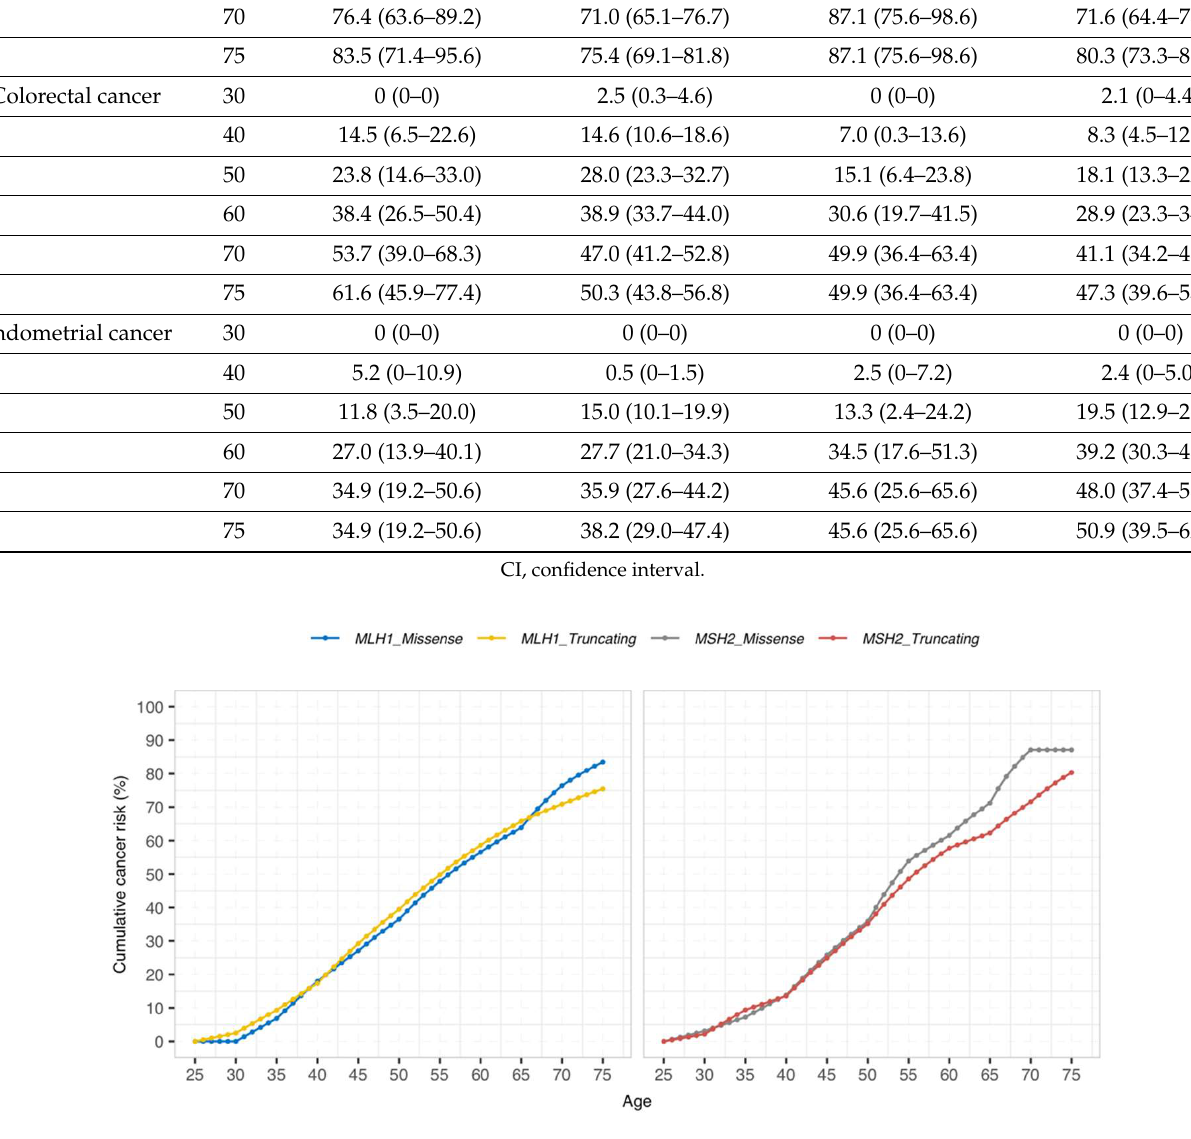
Table 2. Cumulative cancer incidences stratified by age, gene, variant, and organ.